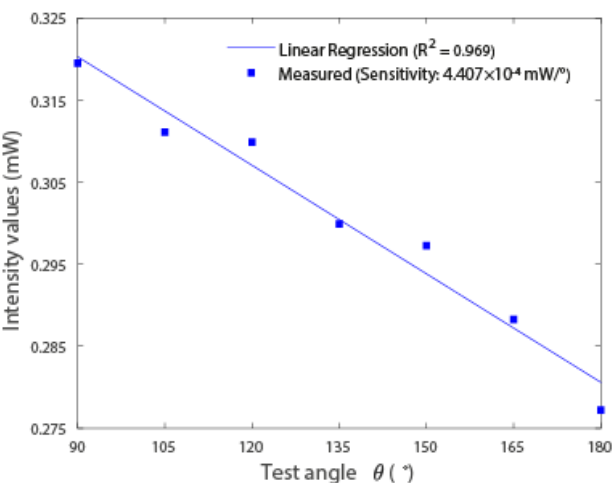
Figure 5. Intensity results (normalized between the minimum and maximum intensity values acquired in each test) in relation to the variation of the angle between ends.